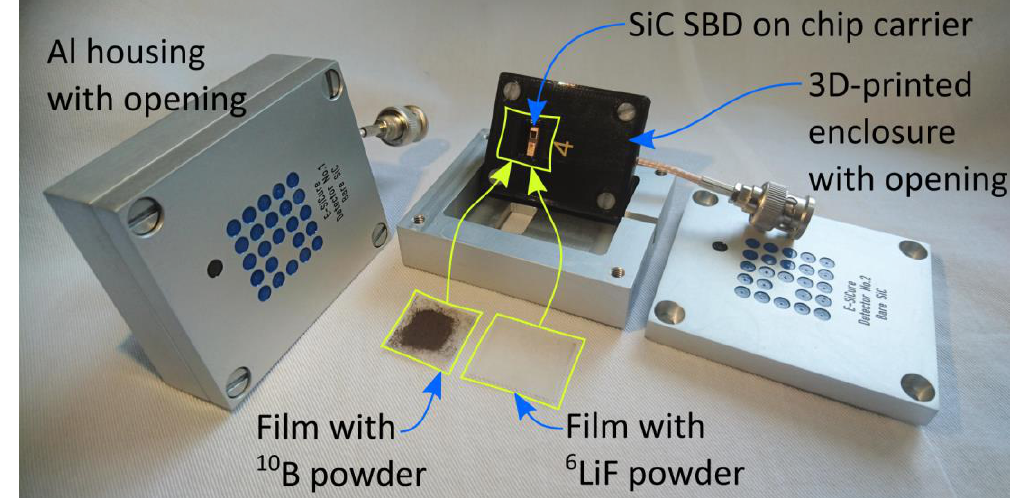
Figure 4: Version 1 SiC detector prototype. Left: assembled detector, right: SiC detector enclosed in 3D-printed enclosure, converting layers, open aluminium